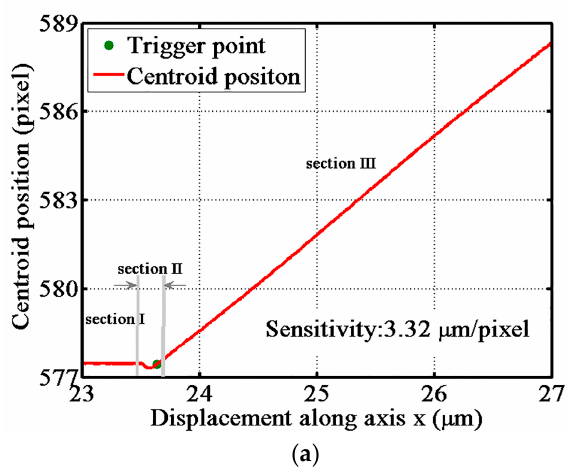
12 of 18 Figure 7. Experimental setup of the ACF probing system: ( a ) experimental schematic diagram of